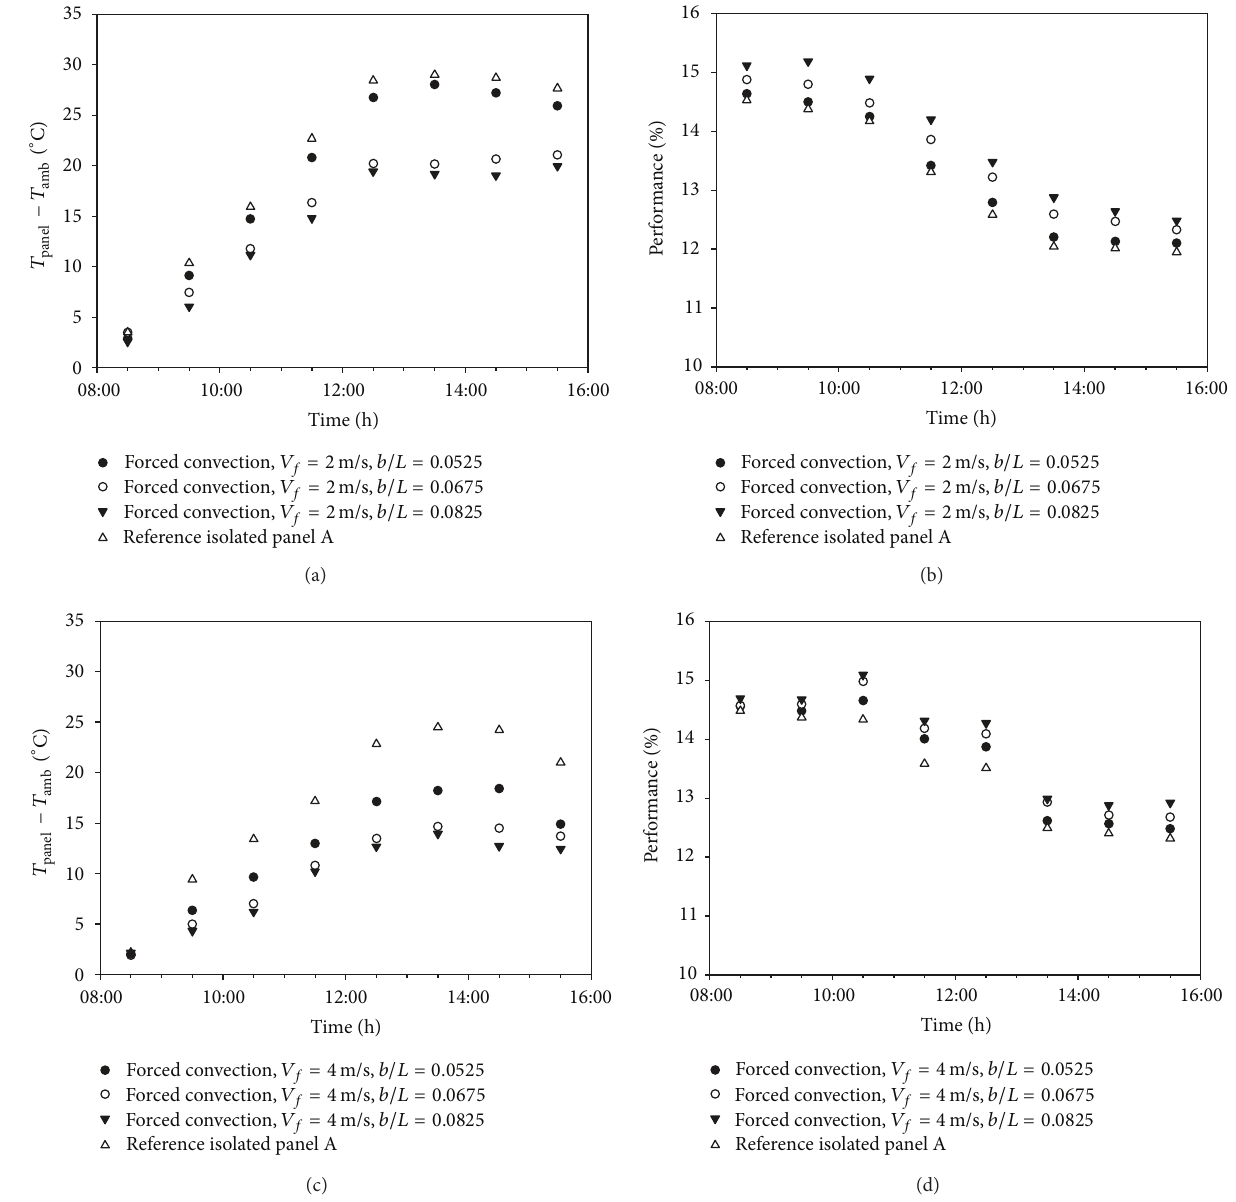
Figure 7: Influence of aspect ratio and forced velocity on the panel temperature and its performance throughout the day. (a) and (b): temperature difference between the panel and the ambient, and panel performance, respectively, for a fan-induced velocity of 2m/s. (c) and (d): temperature difference between the panel and the ambient and panel performance, respectively, for a fan-induced velocity of